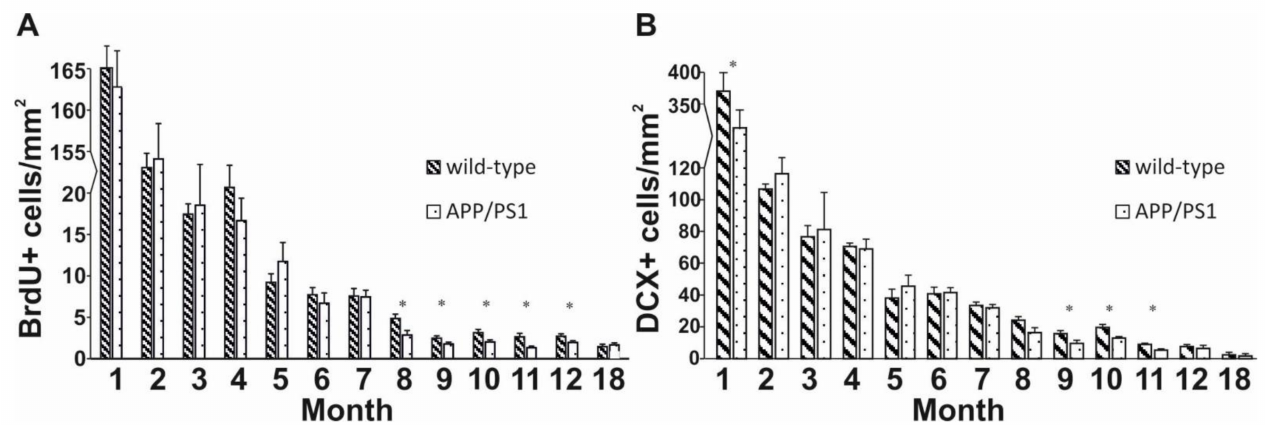
Figure 1. Quantitative results for BrdU and DCX stainings in the dentate gyrus. ( A ) Significant differences were observed among the groups from 8 to 12 months of age: transgenic mice had significantly fewer BrdU+ stem cells than controls. ( B ) DCX+ cells of the DG were analyzed in wild-type and APP/PS1 mice every month. Independent t -tests revealed significant differences in the 9-, 10- and 11-month-old age groups. Data represent mean ± SEM * indicates a significant between-group difference ( p <